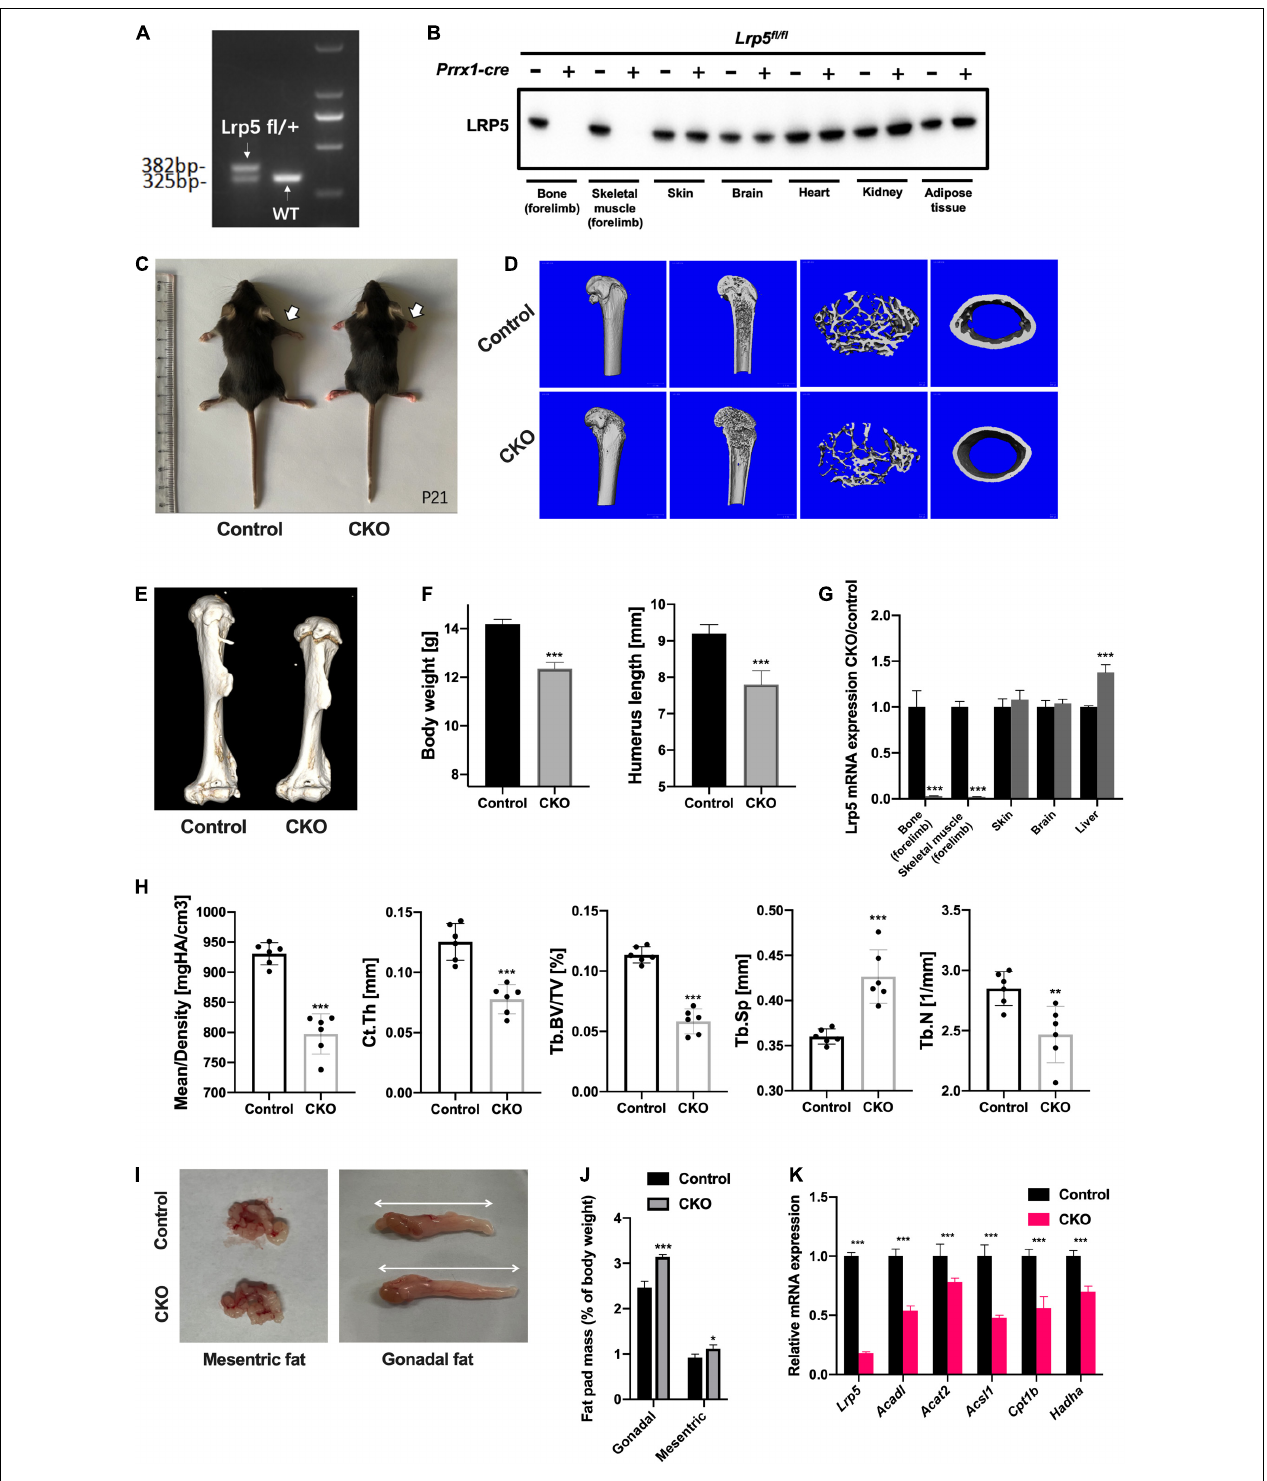
FIGURE 3 | Impaired bone formation and altered adipose tissue distribution in low-density lipoprotein receptor-related protein 5 ( Lrp5 ) fl / fl ;Prrx1-cre conditional knockout (CKO) mice. (A) Electrophoresis of PCR products to identify Lrp5 -flox allele in heterozygous (left band) and wild-type (WT) (right band) samples. The band size for WT allele was ∼ 325 bp and floxed allele was ∼ 382 bp. (B) Protein expression of LRP5 in different organs collected from postnatal day 0 (P0) control ( Prrx1-cre negative) and CKO ( Prrx1-cre positive) mice. The LRP5 expression was significantly abrupted in bone and skeletal muscles from forelimb. (C)